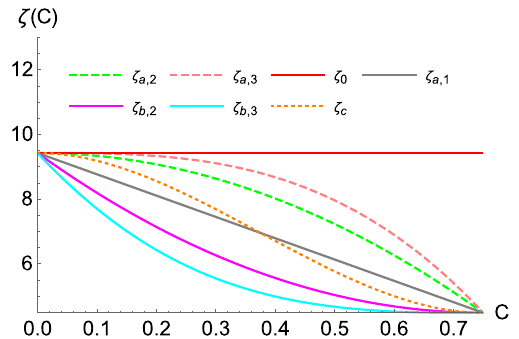
Fig. 1 Different functional forms for ζ( C ) function interpolating between the results at C = 0 and C = 3 / 4